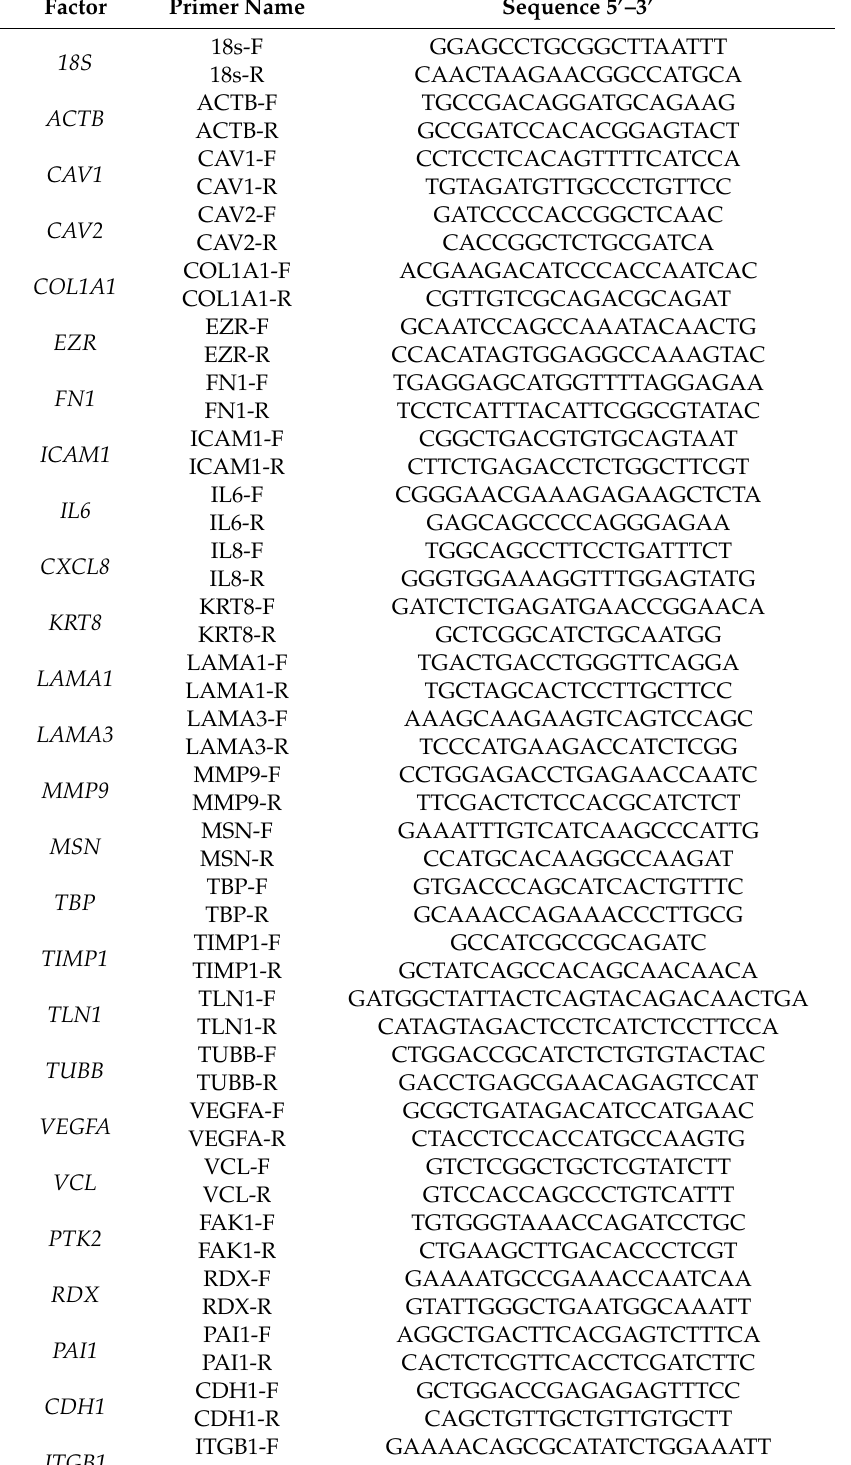
Table 2. List of all the primer sequences used in the quantitative PCR. All the sequences are listed from 5 (cid:48) –3 (cid:48)